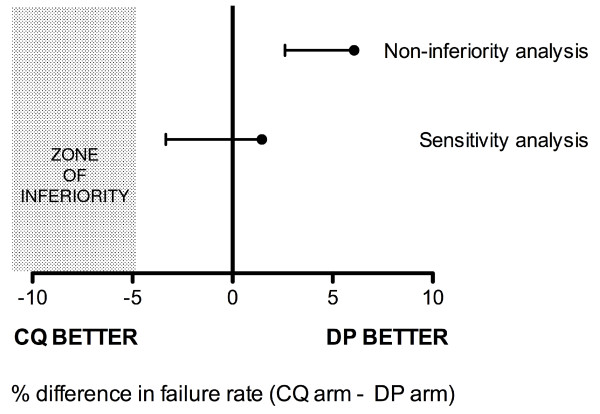
Analysis of primary outcome (cumulative failure rate at day 56). Non-inferiority analysis refers to the pre-specified survival analysis.